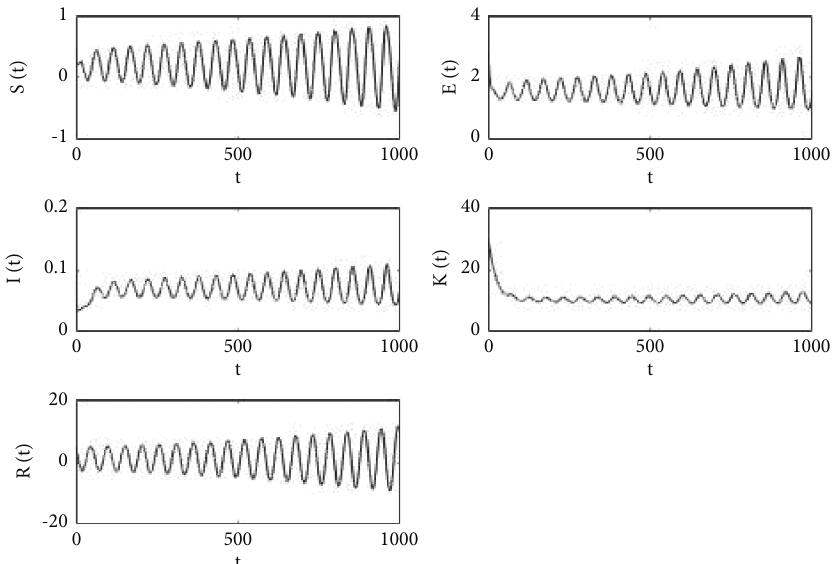
Figure 2: Phase portrait of fractional system (4). When τ asymptotically stable.